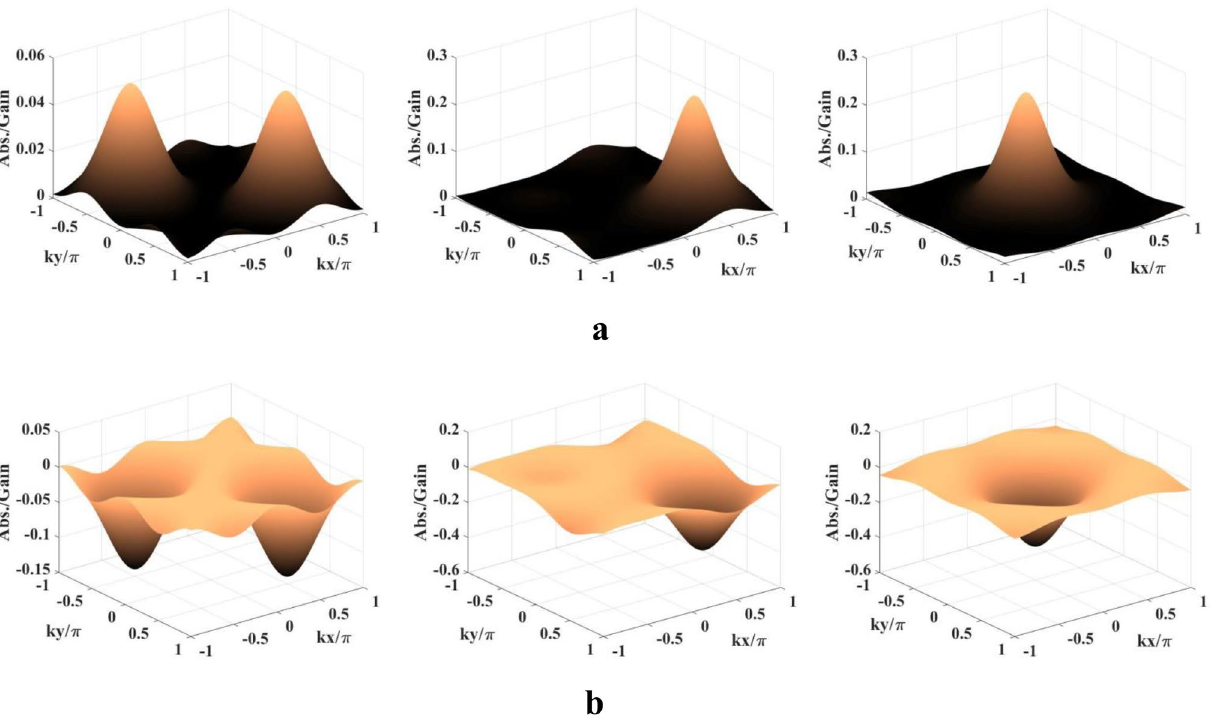
Figure 6. Probe absorption-gain spectra: ( a ) Left - R n 0 = R c 0 = 0, φ = φ n 1 = φ c 1 = φ n 2 = φ c 2 = 0 ; Middle— R n 0 = R c 0 = 1.5 meV, φ = φ n 1 = φ c 1 = φ n 2 = φ c 2 = 0 ; Right— R n 0 = R c 0 = 1.5 meV, φ = 0, φ n 1 = φ c 1 = φ n 2 = φ c 2 = π/ 2 . ( b ) Left— R n 0 = R c 0 = 0, φ = π/ 2, φ n 1 = φ c 1 = φ n 2 = φ c 2 = 0 ; Middle— R n 0 = R c 0 = 1.5 meV, φ = π/ 2, φ n 1 = φ c 1 = φ n 2 = φ c 2 = 0 ; Right - R n 0 = R c 0 = 1.5 meV, φ = φ n 1 = φ c 1 = φ n 2 = φ c 2 = π/ 2 . Parameters: R na = R ca = 2 meV, R m = 0.05 meV, (cid:31) p = 12 meV, (cid:31) c = − 4 meV, and (cid:31) m = 4